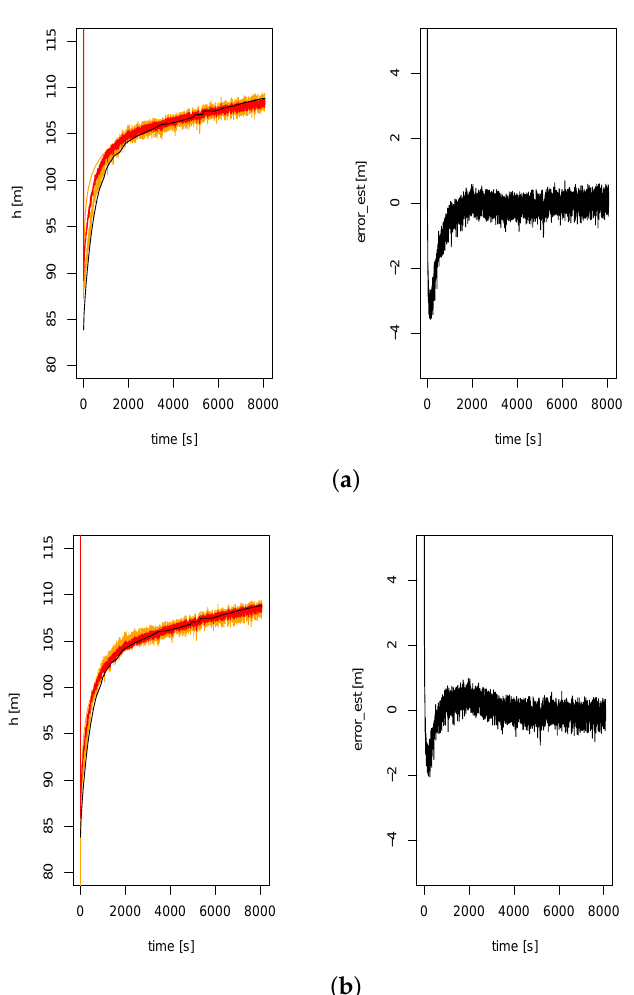
Figure 9. Calibration. ( a ) Left: Water level evolution, measured (black) and simulated (orange and red) with the 1st set of parameters. Right, error estimation evolution. ( b ) Same results as ( a ) with the 2nd set of